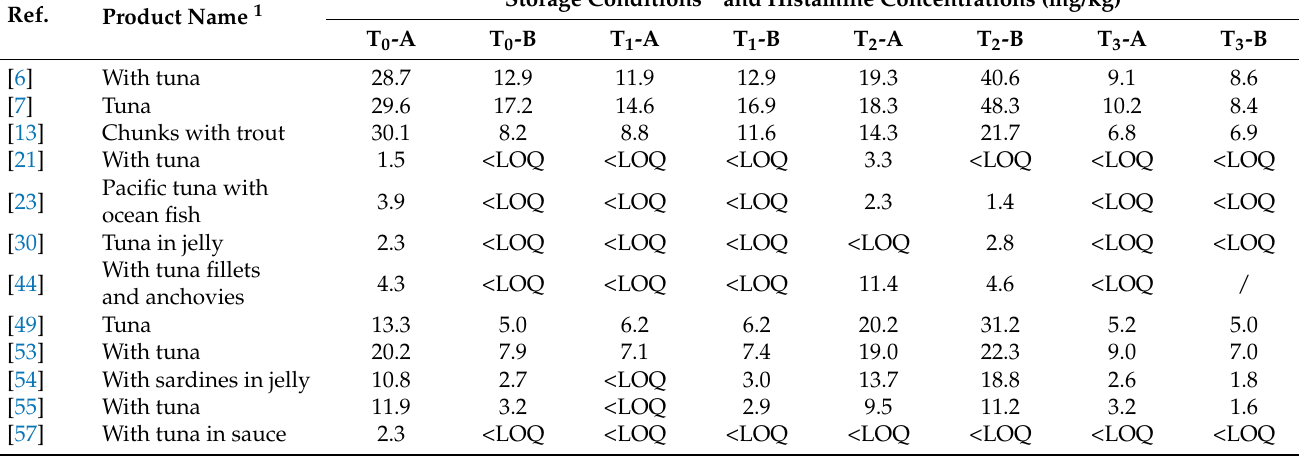
Table 7. Pet-food samples and histamine concentrations after storage in different environmental con-